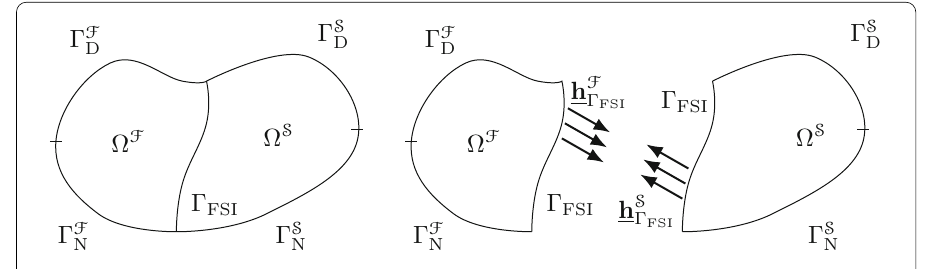
Fig. 1 Problem statement adopted from [25]— Left: The domain (cid:2) is subdivided into a fluid domain (cid:2) F and a structural domain (cid:2) S by the fluid-structure interface (cid:3) FSI . Both subdomains are bounded by Dirichlet and (cid:3) S , Neumann boundaries (cid:3) F and (cid:3) S , and the common fluid-structure interface (cid:3) FSI , boundaries (cid:3) F N N D D respectively. Right: At the interface, kinematic continuity as well as equilibrium of interface traction fields h F (cid:3) and h S (cid:3) are FSI